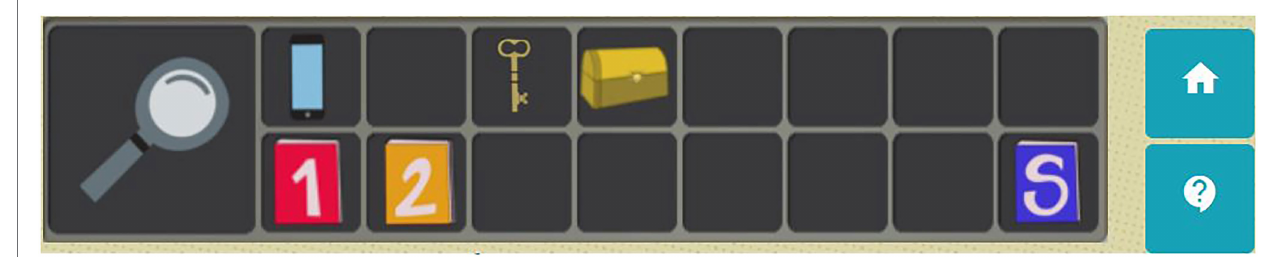
FIGURE 2 | Inventory available in the lowest part of the screen.